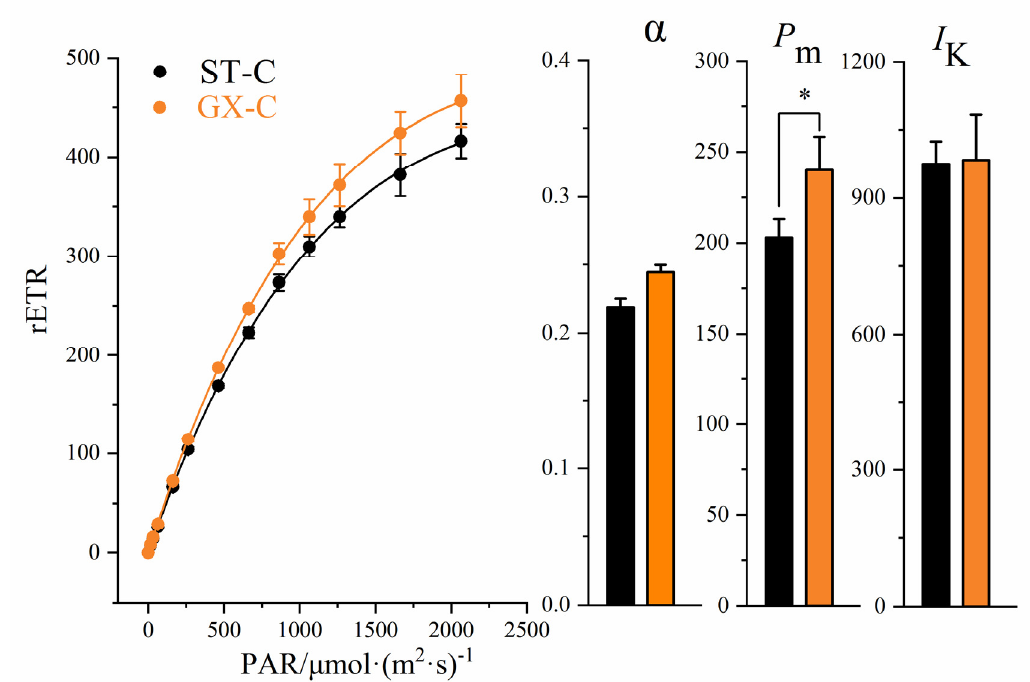
Figure 4. Comparison of the rapid light-response curves, the initial slope of RLC ( α ), the maximal relative electron transport rate ( P m ) and the point of light saturation ( I k ) between ST-C and GX-C. ST-C represents the colonial cell of the P. globosa ST strain (black) and GX-C represents the colonial cell of the P. globosa GX strain (orange). * represents a statistically significant di ff erence of p < 0.05. Table 1. Fatty acid profiles for di ff erent P. globosa cells (mg / g). ST-C represents the colonial cells of the Shantou strain and GX-C represents the colonial cells of the Guangxi strain. ND —not detected. Fatty Acids GX-C ST-C p -Value C14:0 0.156 ± 0.017 2.851 ± 0.453 C16:0 0.397 ±